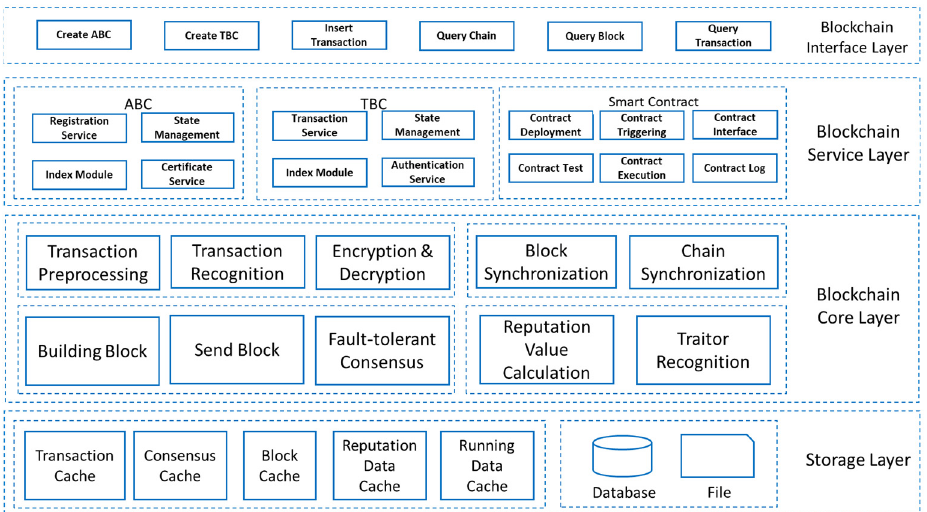
Figure 3. Permissioned blockchain system architecture.